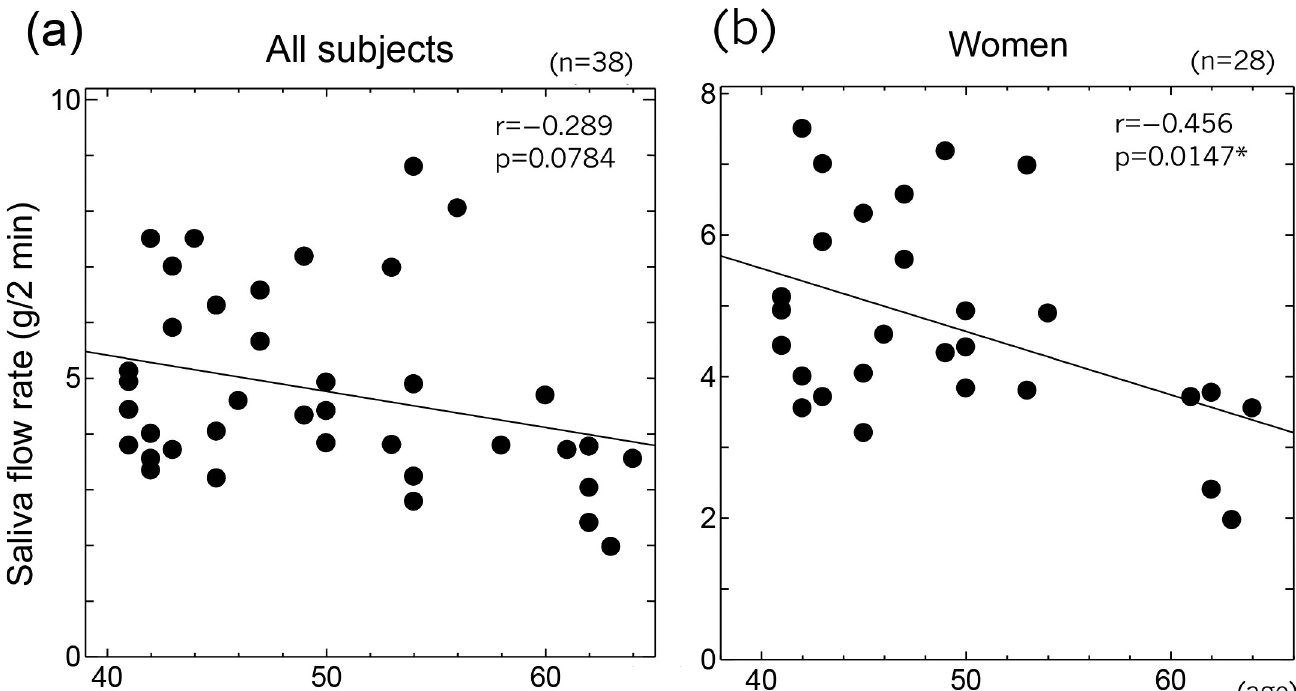
Fig 2. Correlation between age and the saliva flow rate. (a) Overall analysis. Age and the saliva flow rate showed a weak negative correlation that was not significant. (b) Analysis of female subjects. Age and the saliva flow rate showed a significant negative correlation in women.